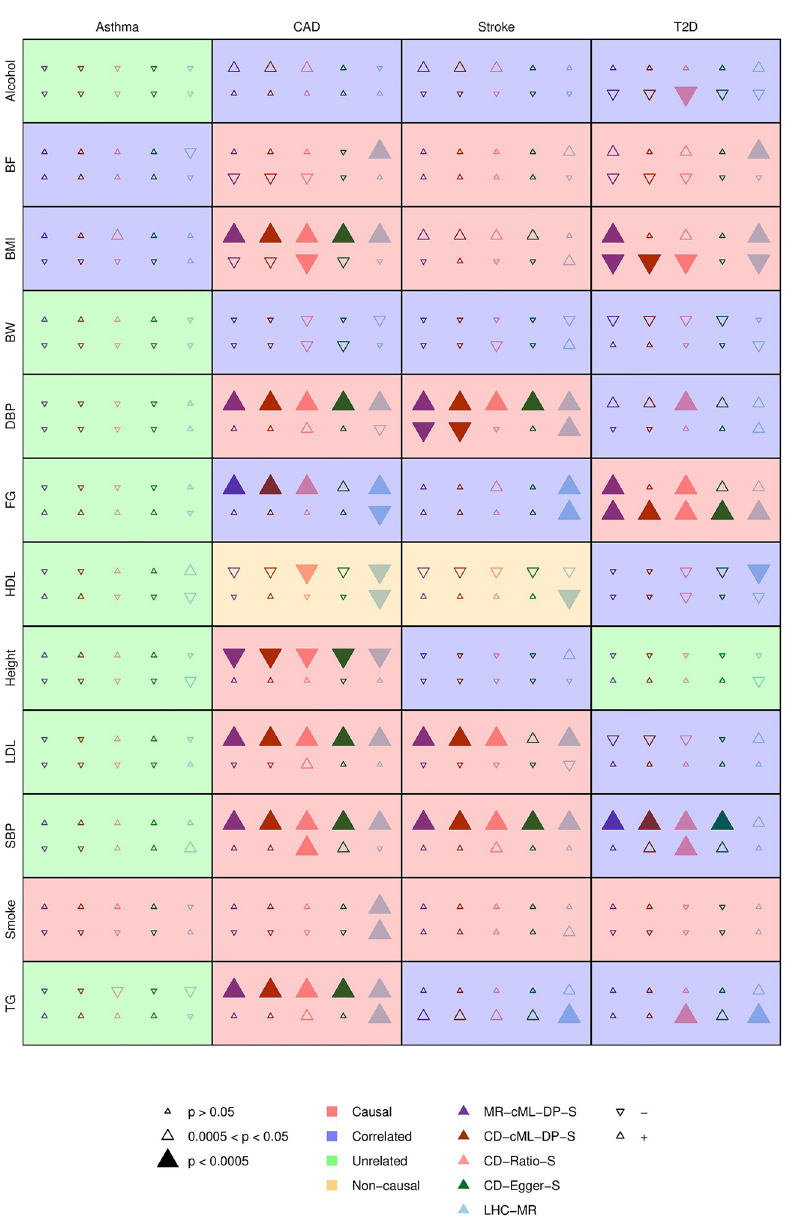
Fig 10. Causal relationship of 48 risk factor-disease pairs. As shown in the legends, the size, color and direction of a triangle represent the statistical significance, method being used, and the direction/sign of the estimated effect. In each cell, the first row is for the causal direction from the risk factor to the disease, and the second row is for the reverse; the background color represents the classification of the relationship from the risk factor to the